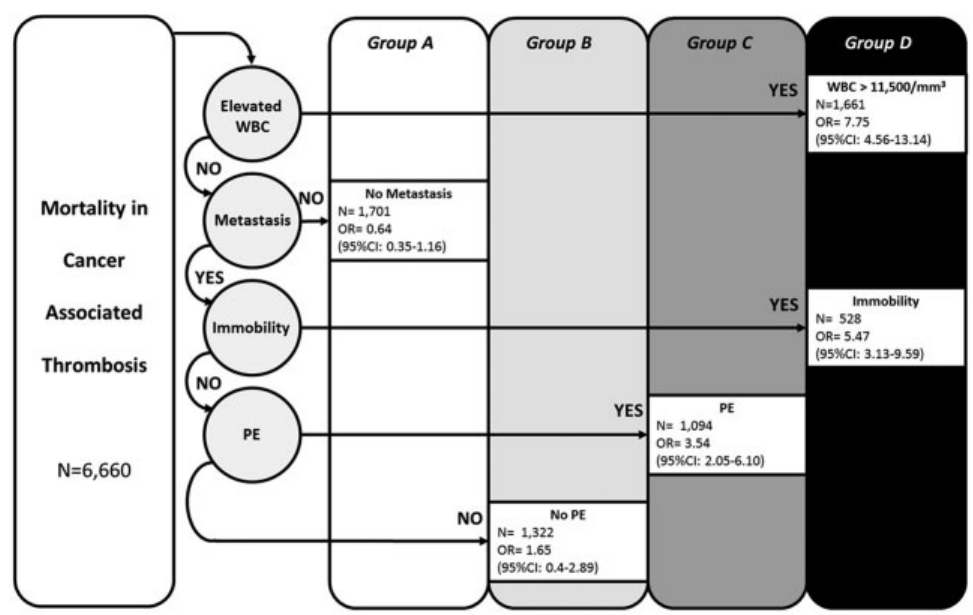
Fig. 1 Groups at risk of early mortality after cancer-associated thrombosis in the derivation cohort. Derivation cohort death risk categories and odds of 30-day mortality. Patients with a missing variable were not carried forward in the count.